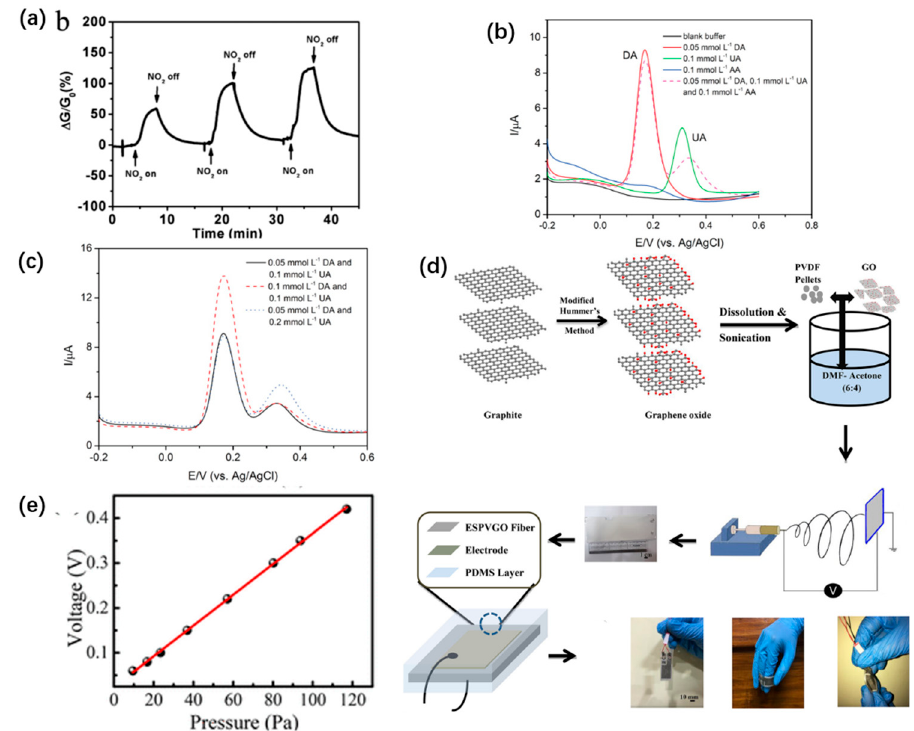
Figure 4. Fabrication of carbon NP interfaces: ( a ) Plot of response versus time for an reduced graphene oxide/polymer composite nanofibers (rGO/P NFs)-based sensor upon exposure to NO 2 gas with a concentration of 500 ppb, 1 ppm, or 2 ppm [84], copyright 2014 American Chemical Society; differential pulse voltammetry (DPV) curves for the polyamide 6/poly allylamine hydrochloride- multiwalled carbon nanotubes (PA6/PAH_MWCNTs) electrode: ( b ) For detection of Dopamine (DA), ascorbic acid (AA), and uric acid (UA), separately, and then in mixtures with the concentrations indicated in the inset; ( c ) for simultaneous detection of DA and UA in concentrations ranging from 0.05 to 0.2 mmol L − 1 [90], copyright 2015 American Chemical Society. ( d ) schematic route for the fabrication of graphene-based piezo- and pyro-electric nanogenerator (GPPNG); ( e ) open-circuit output voltage of the GPPNG under different applied pressure [91], copyright 2019 American Chemical Society;